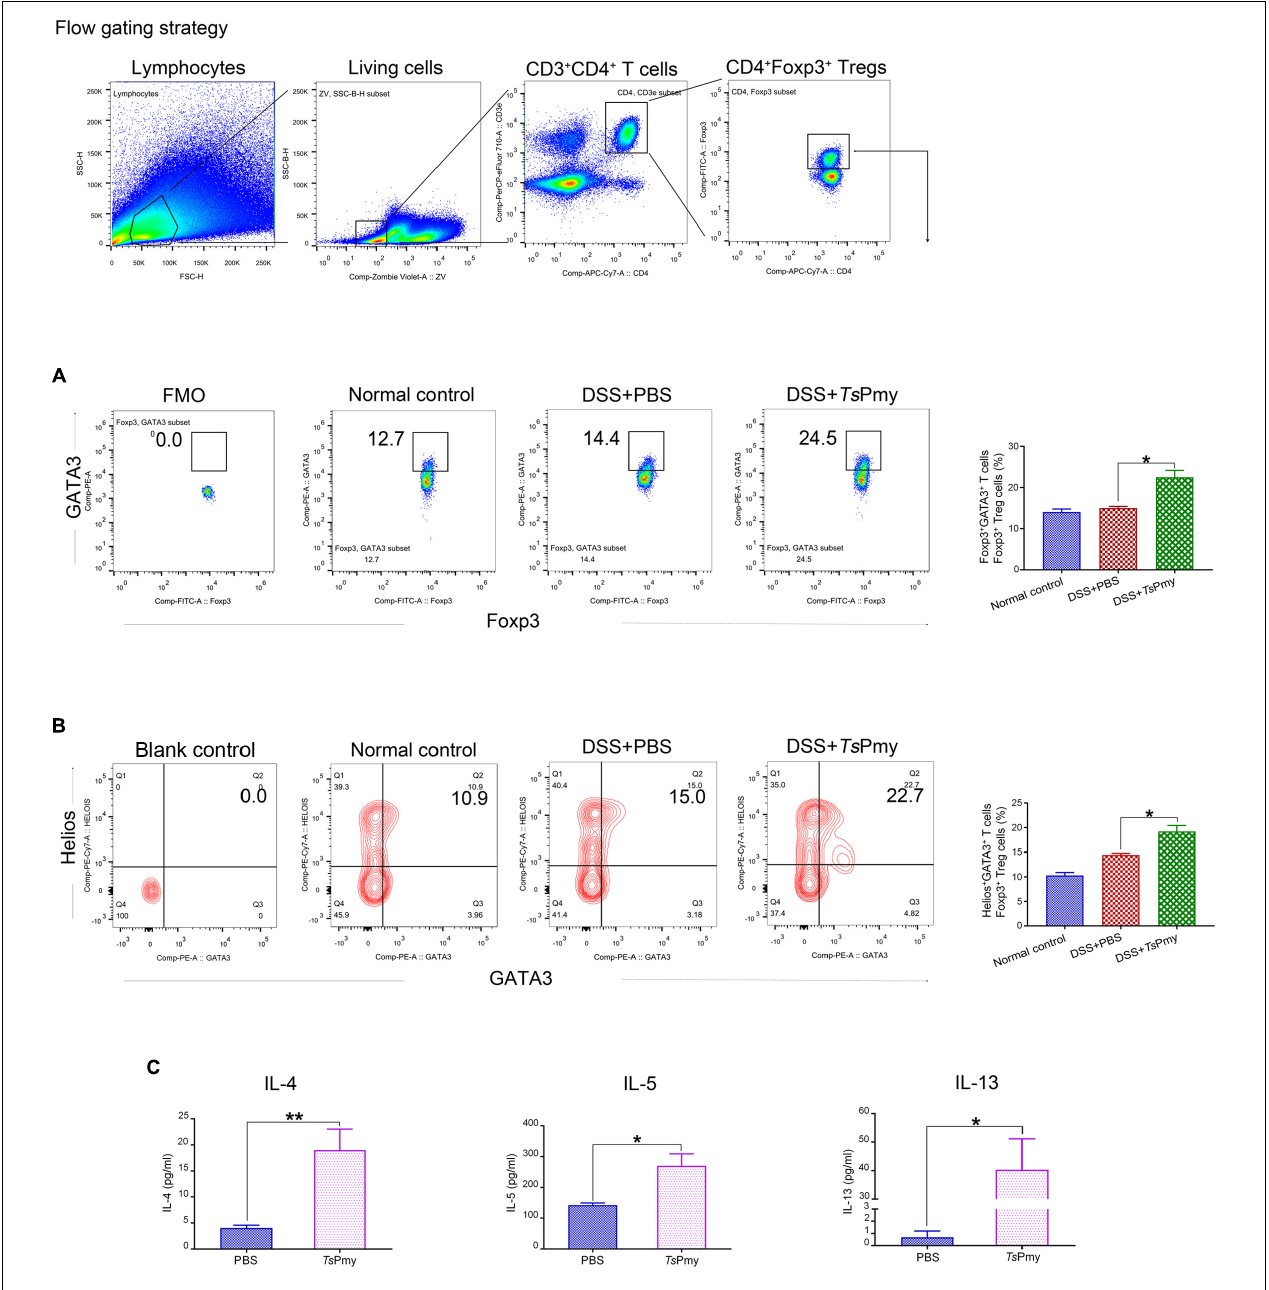
FIGURE 6 | r Ts Pmy increases the GATA3 + Helios + Tregs subset in the Th2 environment. The percentage of GATA3 + cells (A) and Helios + GATA3 + cells (B) in Foxp3 + T cells of cLP from r Ts Pmy- or PBS-treated mice. The antibody of GATA3 (A) was cut in FMO control samples. Blank control of antibodies of GATA3 and Helios (B) was shown. Statistical analyses are shown on the right ( n = 5). (C) The LPMCs were isolated from r Ts Pmy- or PBS-treated mice and stimulated with anti-CD3/CD28 mAb for 48 h. IL-4, IL-5, and IL-13 in the culture supernatants were measured by ELISA ( n = 3). Error bars represent the mean ± SEM. * p < 0.05; ** p < 0.01. LPMCs, Lamina propria mononuclear cells. See also in Supplementary Figure 6